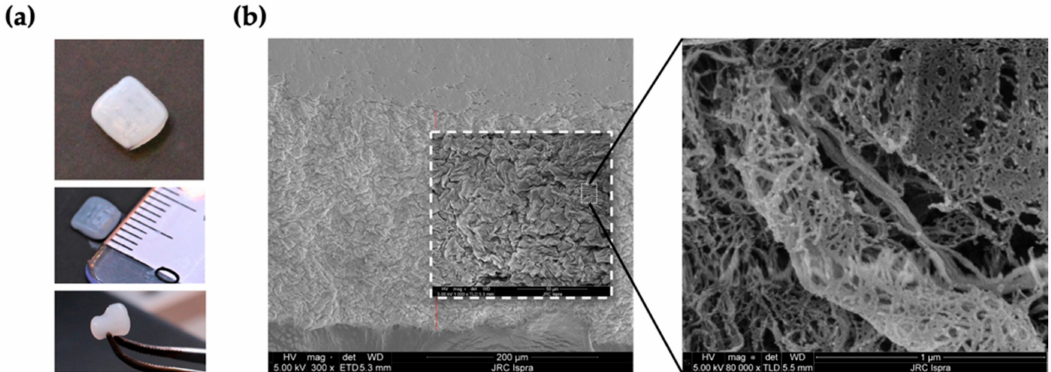
Figure 2. 3D-printed nanofibrillar cellulose / alginate (NFC / A) sca ff old: ( a ) photographs show the macroscopic characteristics and easy handling of the 3D-printed sca ff olds; ( b ) scanning electron microscopy (SEM) micrographs of the 3D NFC / A hydrogel show the ultrastructural morphology of the sca ff old at the top